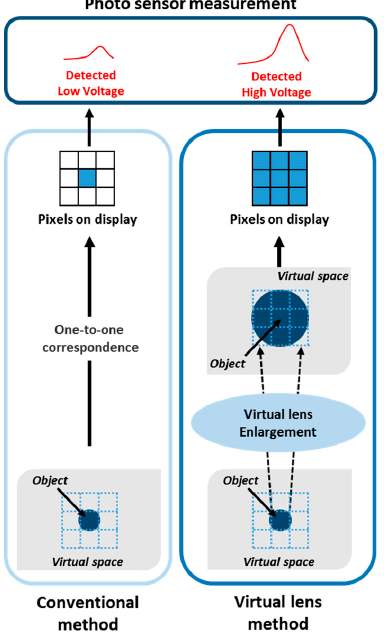
Figure 12. Proposed virtual lens technique for improving the accuracy of the measurement.